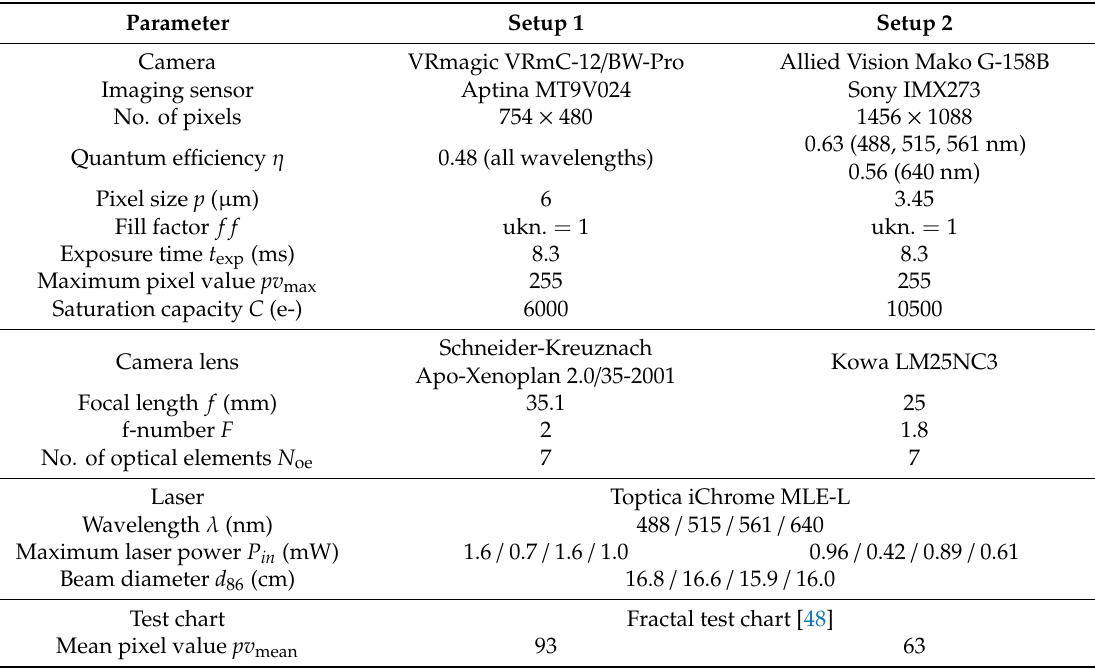
Table 5. Parameters used for the calculation of dazzle spot sizes.